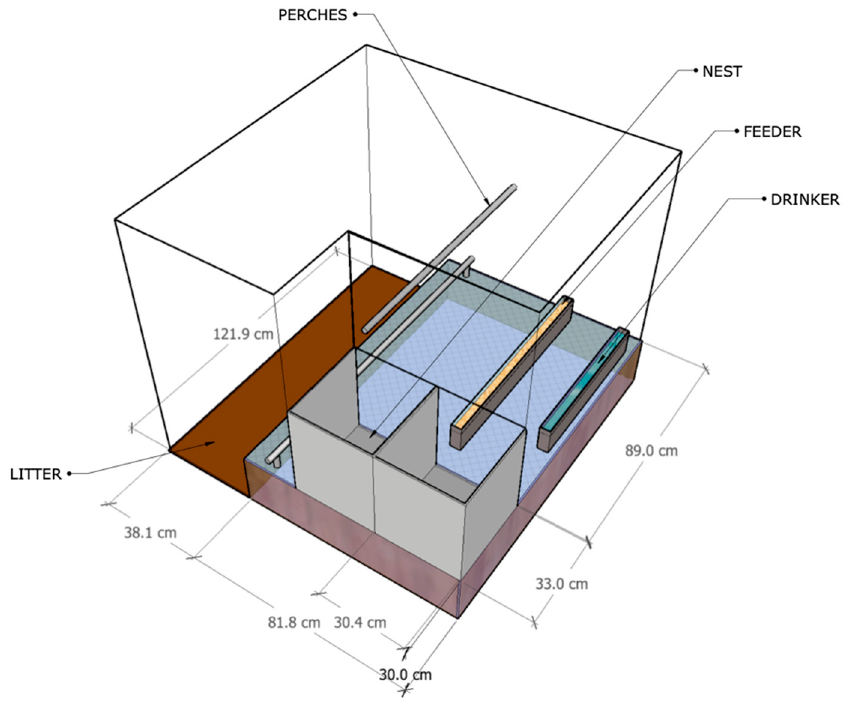
Figure 1. 3D layout of an experimental room.